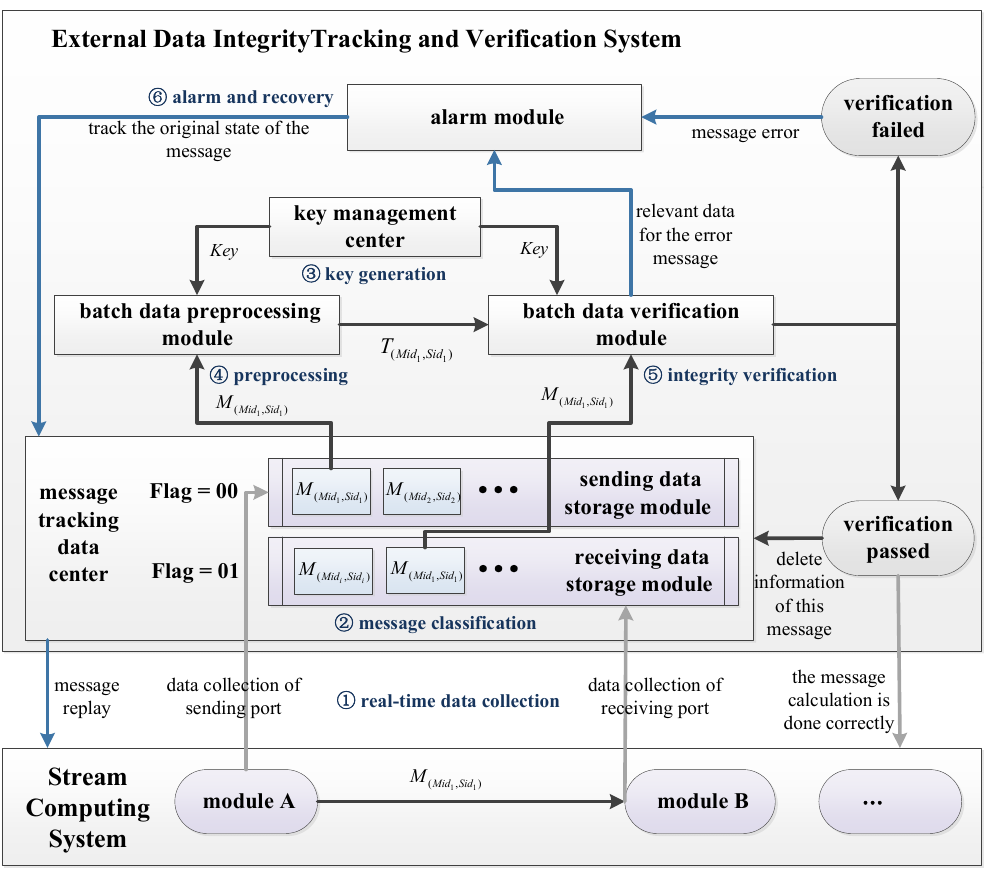
Figure 2. The detailed design of the external data integrity tracking and verification system.